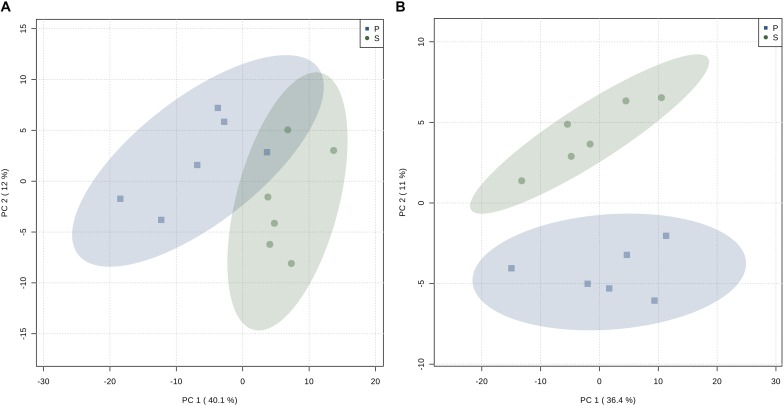
Principal Component Analysis (PCA) scores plot of: (A) CPMG spectra of the liver aqueous fraction, and (B) 1D 1H NMR spectra of the muscle aqueous fraction of barramundi (L. calcarifer) fed with high protein (P) or (S) high starch diets.